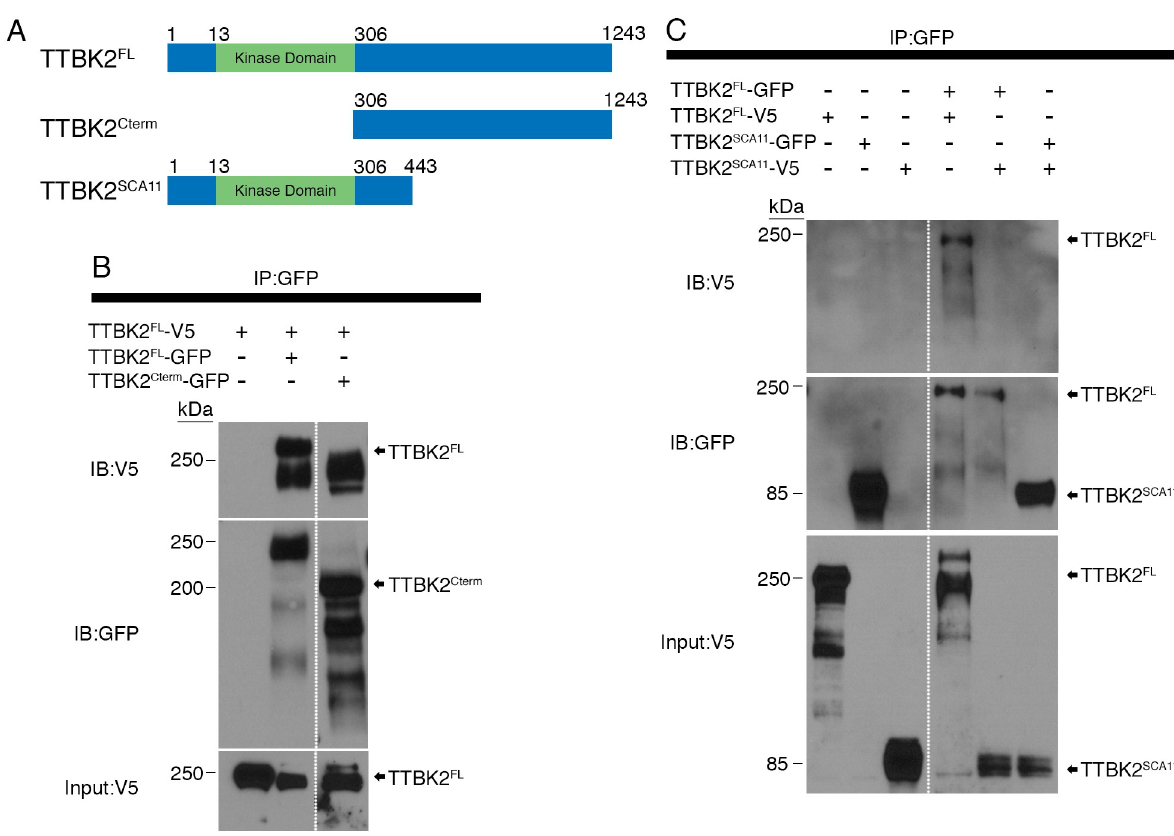
Fig 3. TTBK2 homodimerizes through its C-terminus. (A) A schematic representing the various TTBK2 truncations used for co- immunoprecipitation. TTBK2 FL corresponds to full length mouse TTBK2. TTBK2 CTerm is the amino acids C-terminal to the kinase domain: 306– 1243. TTBK2 SCA11 corresponds to one of the disease-associated mutations, and includes amino acids 1–443. Each is tagged with either V5 or GFP at the N-terminus as indicated in B and C. (B) Construct were expressed together as indicated in HEK 293T cells, which were lysed and subjected to immunoprecipitation using anti-GFP conjugated beads. Full length TTBK2 tagged with V5 (TTBK2 FL -V5) was co-transfected with GFP-tagged full- length TTBK2 (TTBK2 FL -GFP) or TTBK2 Cterm . TTBK2 FL -V5 interacted with TTBK2 FL -GFP and TTBK2 Cterm -GFP. Dashed line indicates that the blot image was cropped to remove bands that were not part of the current analysis. Input protein amount was 10% of total lysate for all conditions. (C) Constructs encoding either TTBK2 FL or TTBK2 SCA11 tagged with either GFP or V5 as indicated were expressed in HEK293T cells and subjected to immunoprecipitation using anti-GFP conjugated beads. Again, TTBK2 FL -V5 and TTBK2 FL -GFP co-precipitated, however TTBK2 FL did not co- precipitate with TTBK2 SCA11 -GFP, and TTBK2 SCA11 -V5 did not co-precipitate with TTBK2 SCA11 -GFP. Input protein amount was 10% of total lysate for all conditions. Dashed line indicates that the blot image was cropped to remove bands that were not part of the current analysis.